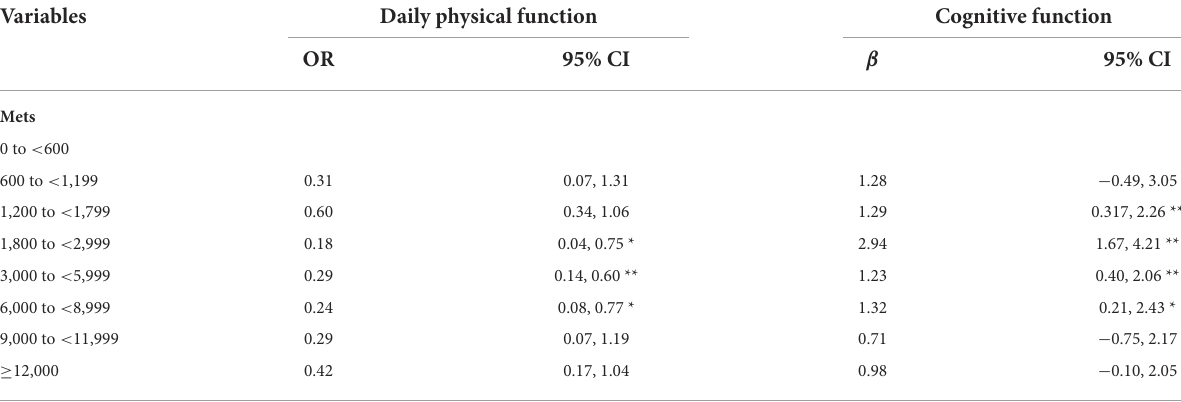
TABLE 3 Associations between METs and the daily physical activity ability and cognitive function of patients with heart disease. Variables Daily physical